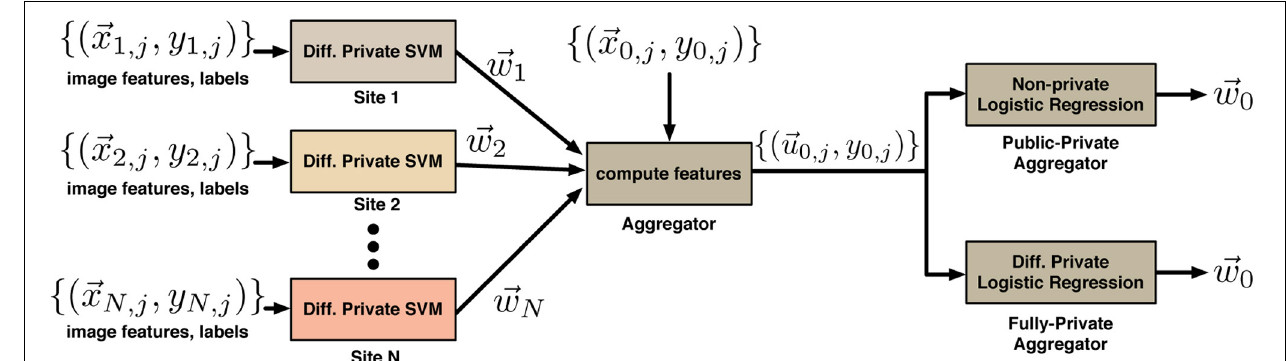
its own data set. The aggregator can learn a classifier using its own data using a non-private algorithm (if its data is public) or a differentially private algorithm (if its data is